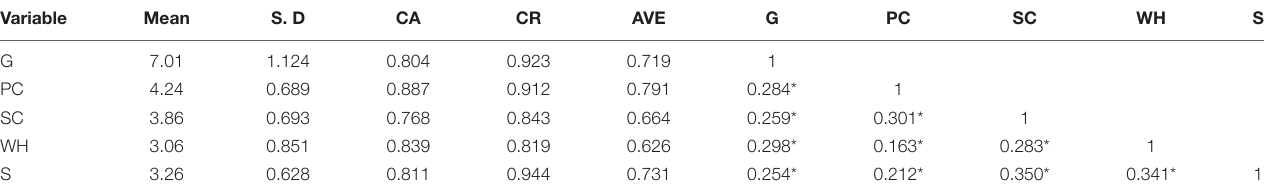
TABLE 2 | Descriptive statistics and correlation matrix.